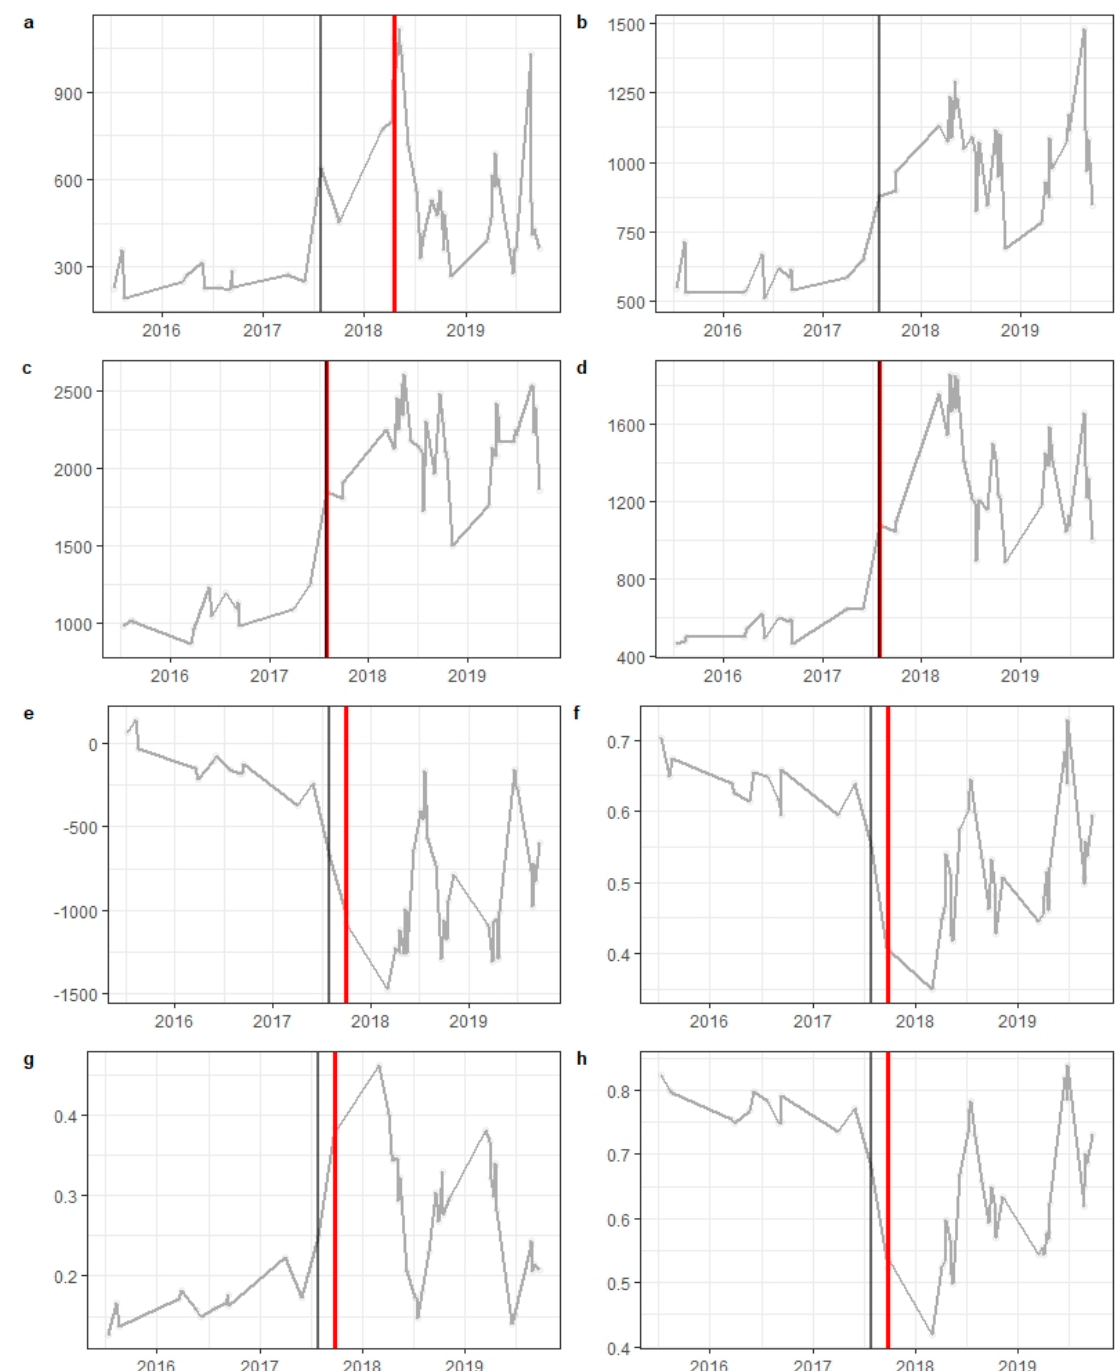
Figure 5. The example of spectral trajectories for a selected pixel: red vertical lines—detected break dates, black vertical line—real change date.; ( a ) VIS R, ( b ) RE1, ( c ) SWIR1, ( d ) SWIR2, ( e ) TCW, ( f ) NDMI, ( g ) MSI, ( h ) NBR.